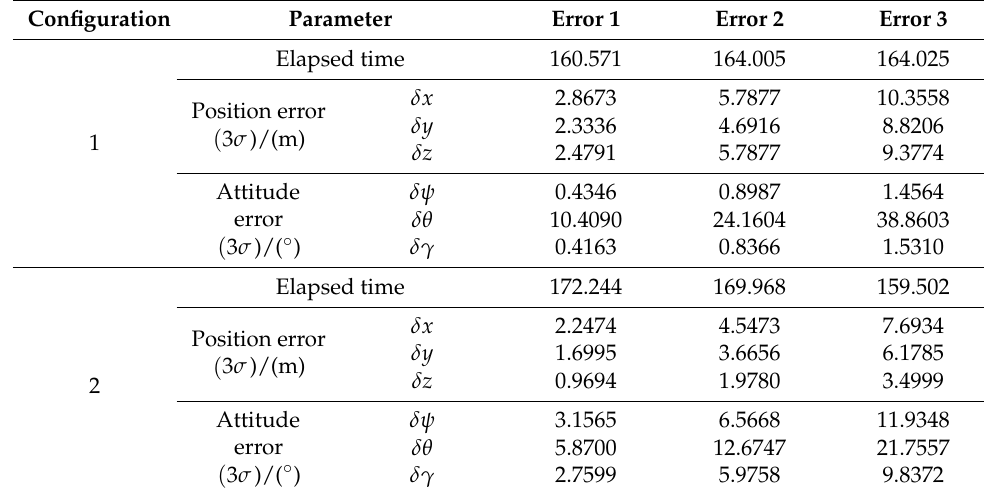
Table 3. Monte Carlo results under configuration 1 and configuration